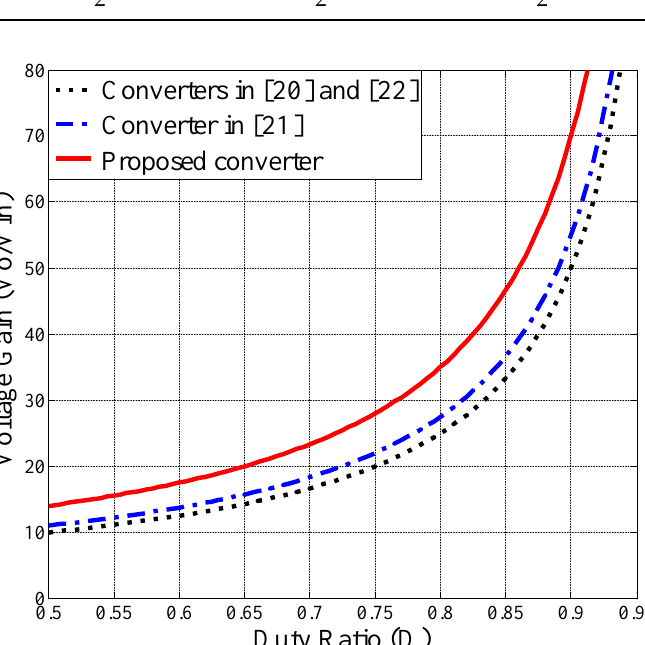
Figure 7. Voltage gains versus duty ratio with turns ratio n = 1.5 .